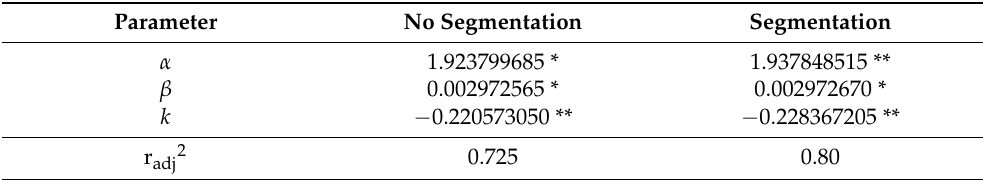
Table 1. Parametrization and adequacy of predicting in the sigmoid Gompertz function for the superpixel-intensity of flower’s color upon the architecture’s